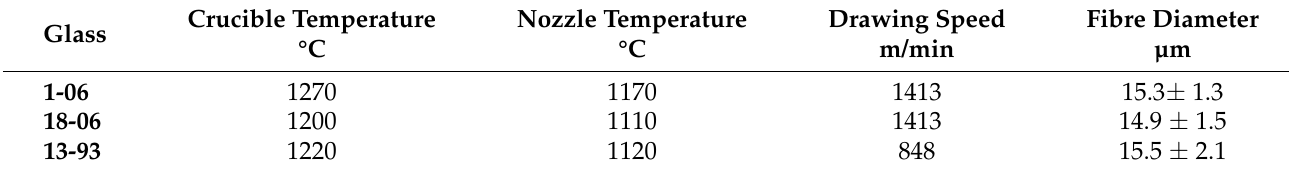
Figure 1. Schematic illustration of the fibre drawing plant. Table 4. Drawing parameters of the produced